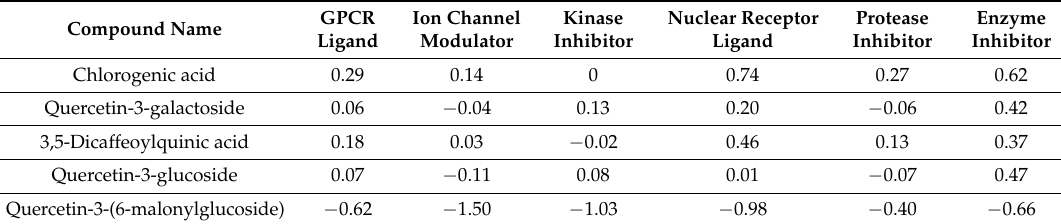
Table 1. Bioactivity of the main components present in the C. olitorius